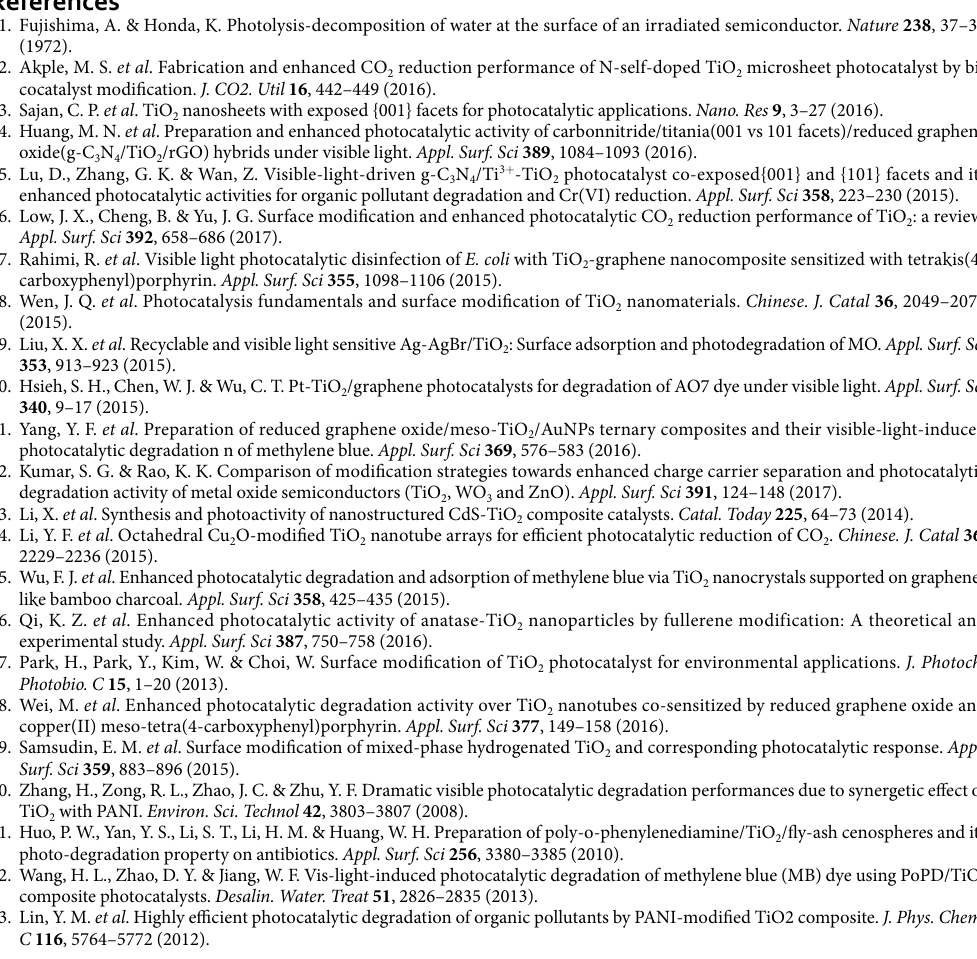
PoPD/TiO 2 . The results indicated that PoPD/TiO 2 nanocomposites exhibited good photocatalytic activity (appar- ent first-order rate constants of 0.0021 min − 1 for TiO 2 and 0.0033 min − 1 for P/T(1/4)) and stability (recycled 5 times, 15 hours of operation). The photocatalytic activity of PoPD/TiO 2 was influenced by the initial pH and concentration of the photocatalyst. Based on radical trapping experiments and ESR measurements, the origin of oxidizing ability of PoPD/TiO 2 nanocomposites on photocatalytic degradation of MB was proposed, which taking into account of ·OH was the first important ROS and ·O 2 − was the second important ROS. The photocatalytic activity enhanced mechanism has been proposed, taking into account the photosensitization effect (UV-Vis DRS) and synergetic effect of TiO 2 with PoPD (Synergetic Factor and EIS).